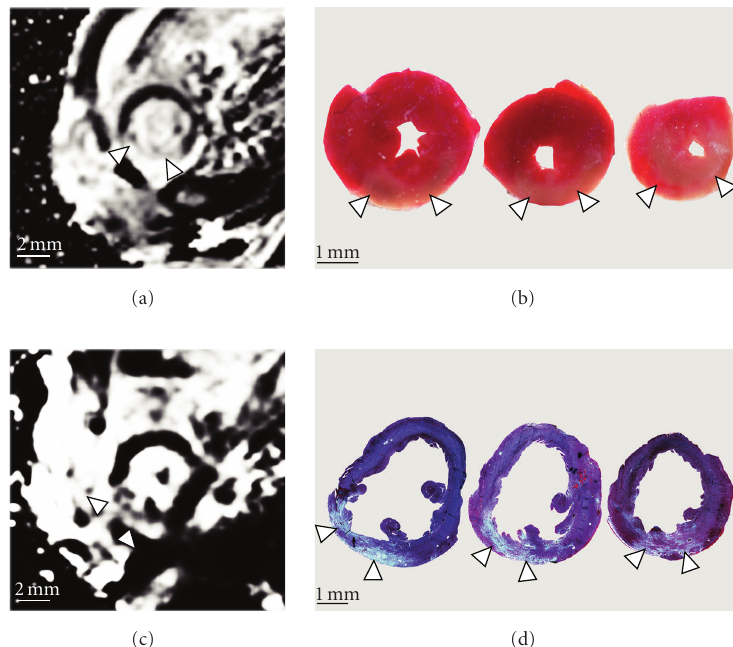
Figure 1: Myocardial infarction shown by LGE in magnetic resonance imaging and histological staining. Representative slices taken from the left ventricle: LGE shown by phase-sensitive inversion recovery trueFISP sequence (PSIR) (a) compared with 3 successive slices from the same heart after triphenyl tetrazolium chloride staining (b) 24h after procedure. LGE shown by PSIR sequence (c) compared with 3 slices from the same heart after trichrome staining (d) 1 week after procedure. Arrows indicate area of infarction.